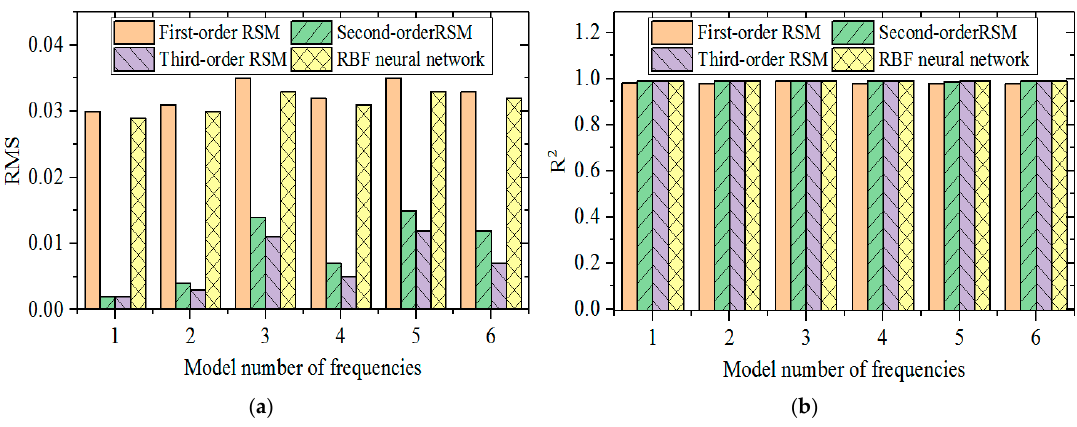
Figure 9. The root mean square (RMS) and coefficient of determination (R 2 ) of four approximate models. ( a ) The RMS of four approximate models; ( b ) The R 2 of four approximate models. Response surface model (RSM).